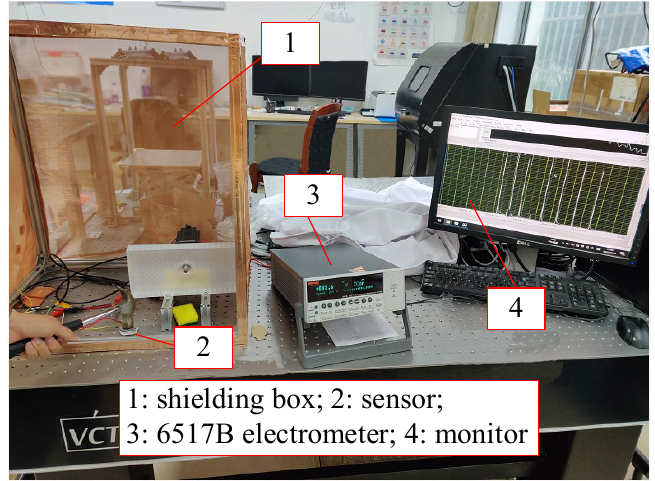
Figure 12. The platform for sensing unit test.